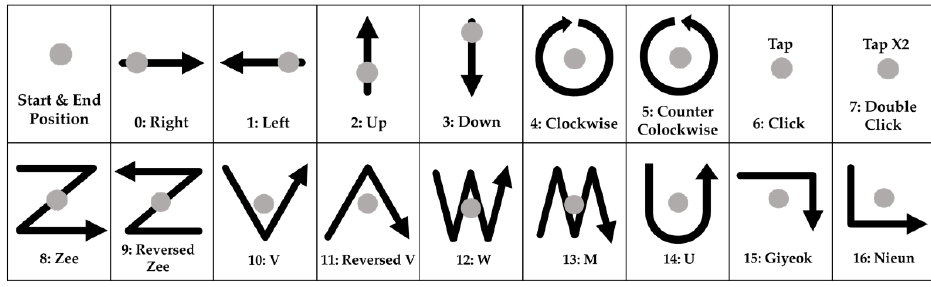
Figure 8. Definition of 17 finger gestures.